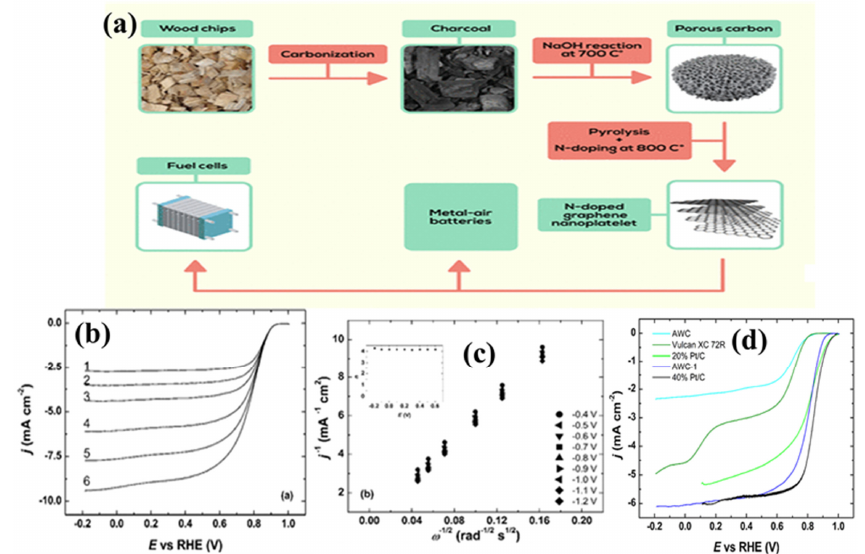
Figure 11. ( a ) Schematic diagram of N–doped carbon preparation, ( b ) RDE polarization curves of N–doped wood–based catalyst (AWC–1) in O 2 –saturated 0.1 M KOH ( ν = 10 mV s –1 , and ω = (1) 360, (2) 610, (3) 960, (4) 1900, (5) 3100, and (6) 4600 rpm), ( c ) K–L plots for ORR on a N–doped wood–based electrode in 0.1 M KOH at different potentials (inset: the changes of n values in the studied potential range), ( d ) LSV polarization curves of different catalyst in O 2 –saturated 0.1 M KOH. ν = 10 mV s − 1 , ω = 1900 rpm, adapted from [79].